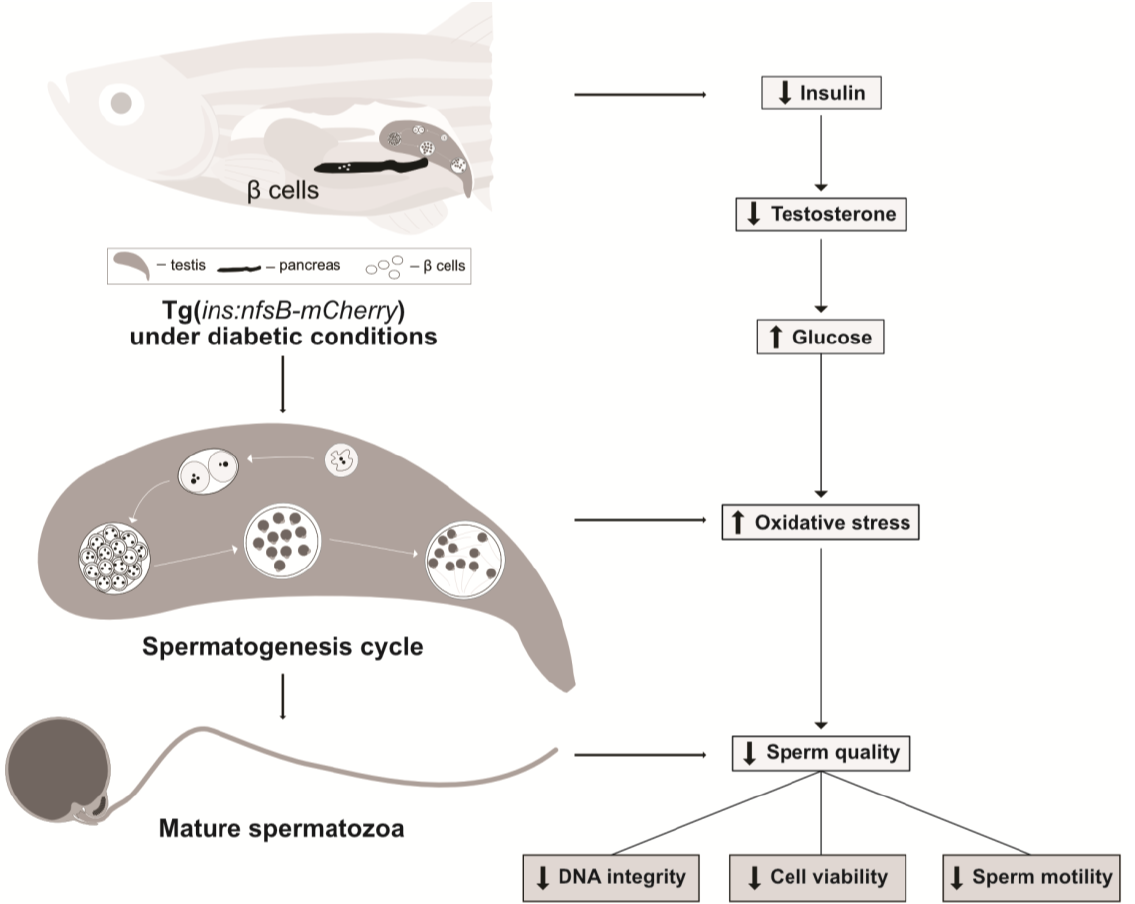
Figure 6. Hypothetic model of putative effects of diabetes on sperm quality in type I diabetes zebrafish strain [Tg( ins : nfsb-mCherry )].